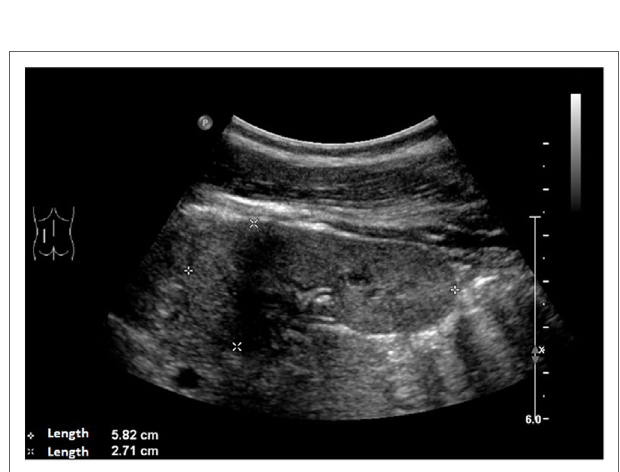
FIgURe 4 | Ultrasound of the left kidney with a length of 5.8 cm ( < 1st percentile).